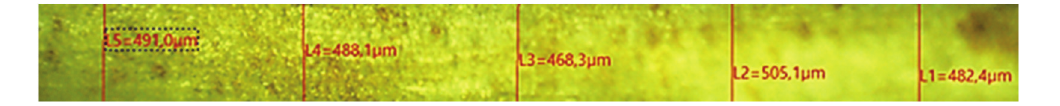
Figure 4: Measurement of date palm fibers diameter by optical microscope